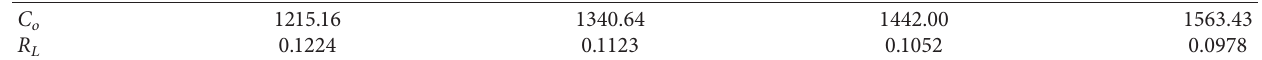
Figure 9: Langmuir plot for the adsorption of TPC onto AJB. Adsorbent dosage � 1.0g 10mL of OMW, pH � 6, contact time � 3h. Table 2: Calculated values of separation factor R L for the adsorption of TPC onto AJB at 303K.